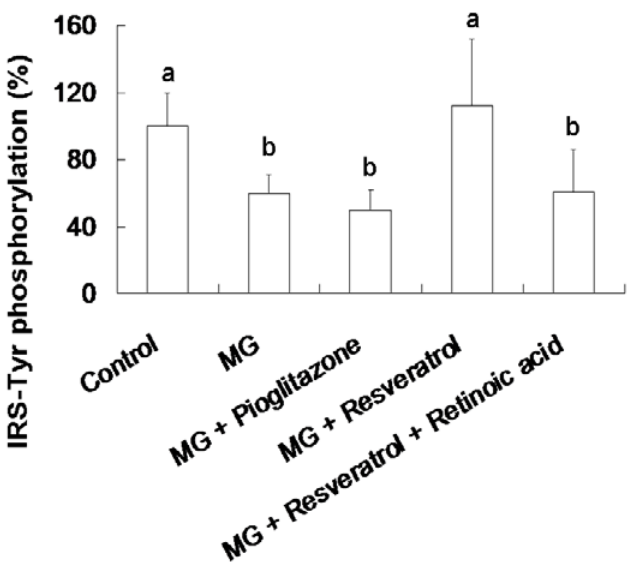
Figure 4. Elevation of hepatic insulin receptor substrate 1 (IRS-1) tyrosine